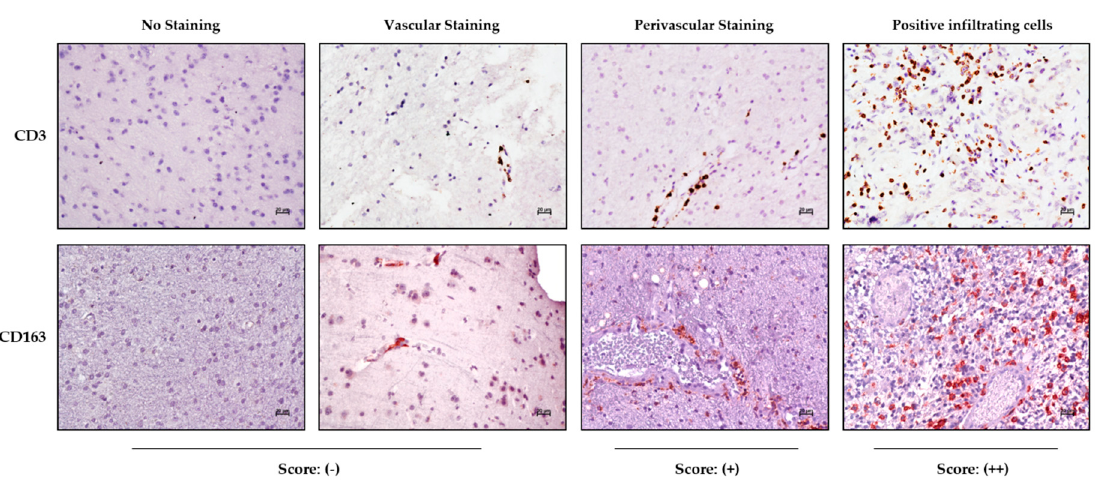
Figure 1. Localization of immune cells in periphery area and tumor core. Representative cases with negative / vascular staining ( − ), perivascular positivity ( + ) or infiltrating cells ( ++ ) in the parenchyma of tissue for CD3 and CD163 (magnification, 20 ×